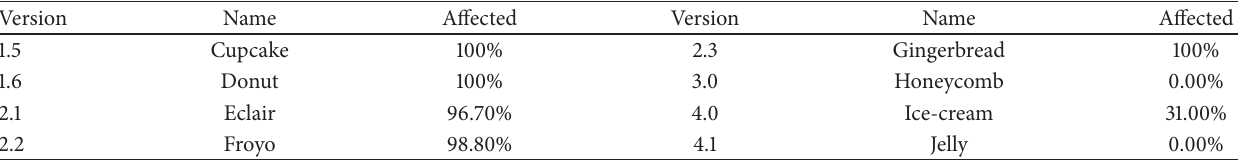
Table 8: Percentage of devices that can be affected by the most common privilege escalation vulnerabilities, depending on the Android OS